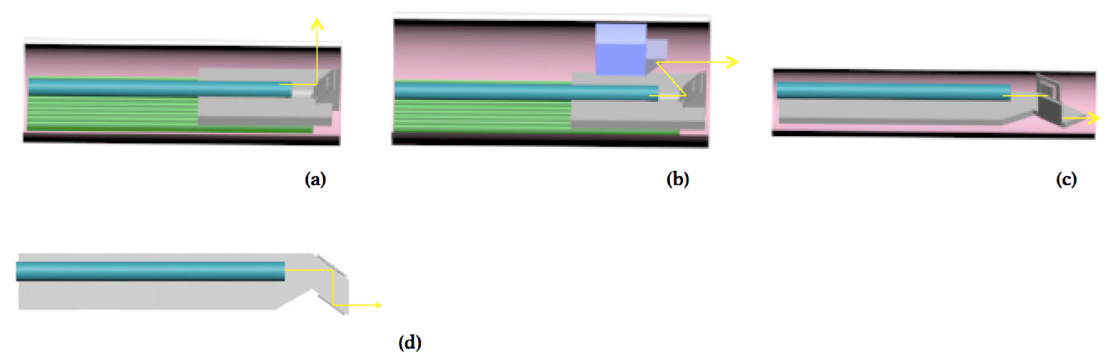
Figure 2. Various microelectromechanical system (MEMS) probe designs. ( a ) A typical side-view scanning probe. ( b ) A typical forward-view probe with a beam folding mirror to fold the optical beam. ( c ) A novel forward-view probe with two vertical mirrors on a silicon substrate. ( d ) A top view of the novel forward-view probe, showing the light path inside the probe.